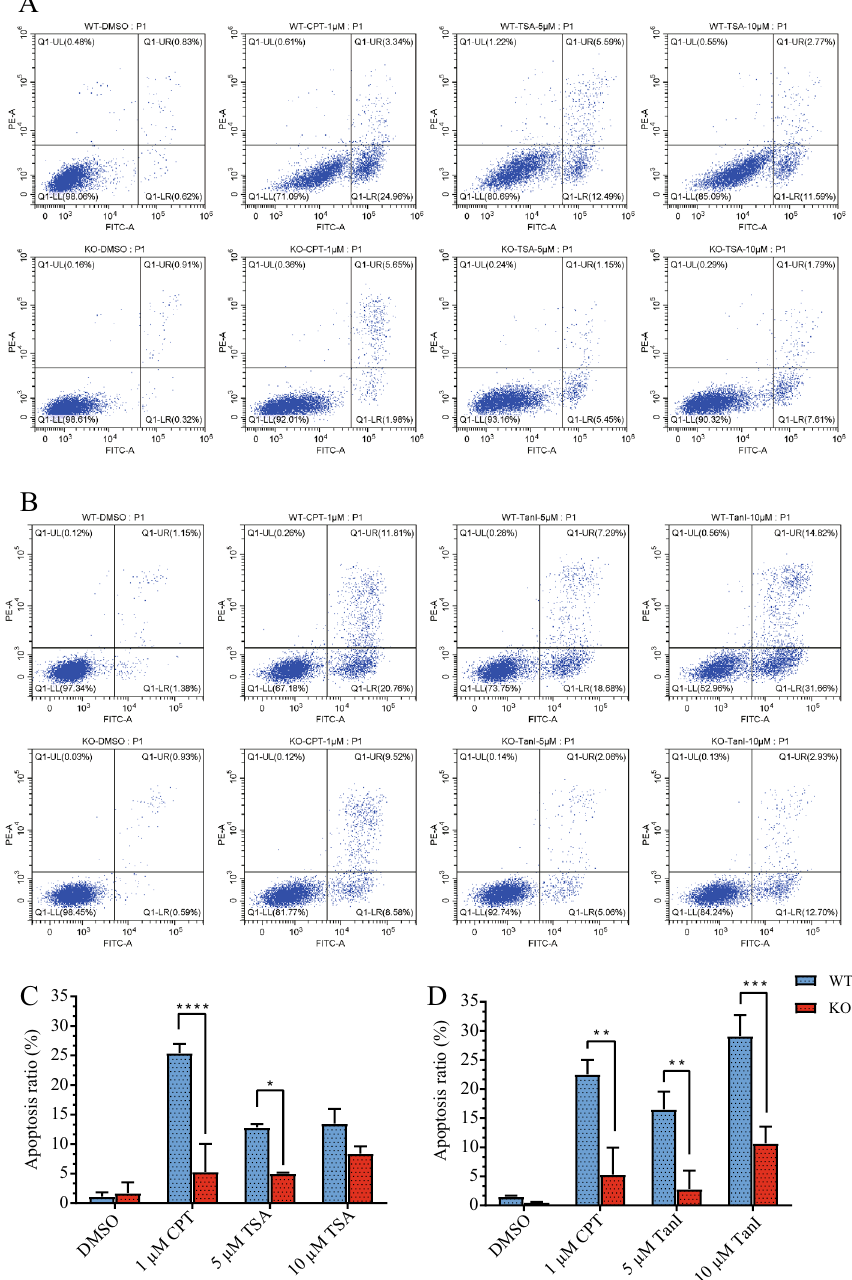
Figure 6. TSA inhibition cell growth is partially dependent on FHIT. Flow cytometry assay of apoptosis analysis for TSA ( A ) and TanI ( B ), FHIT WT and KO HCT116 cells were treated with the indicated concentrations of ligand for 24 h, then cells were stained for PI and Annexin V before flow cytometry analysis. ( C ) Qualification of V-FITC/PI measurements of apoptotic cells in ( A ). The experiment was repeated three times in each group. Data were analyzed using two-way ANOVA, one asterisk stands for P < 0.05, four asterisks stand for P < 0.0001. ( D ) Quantification of V-FITC/PI positive apoptotic cells in ( B ). The experiment was repeated 3 times in each group. Data were analyzed using two-way ANOVA, two asterisks stand for P < 0.001, three asterisks stand for P <